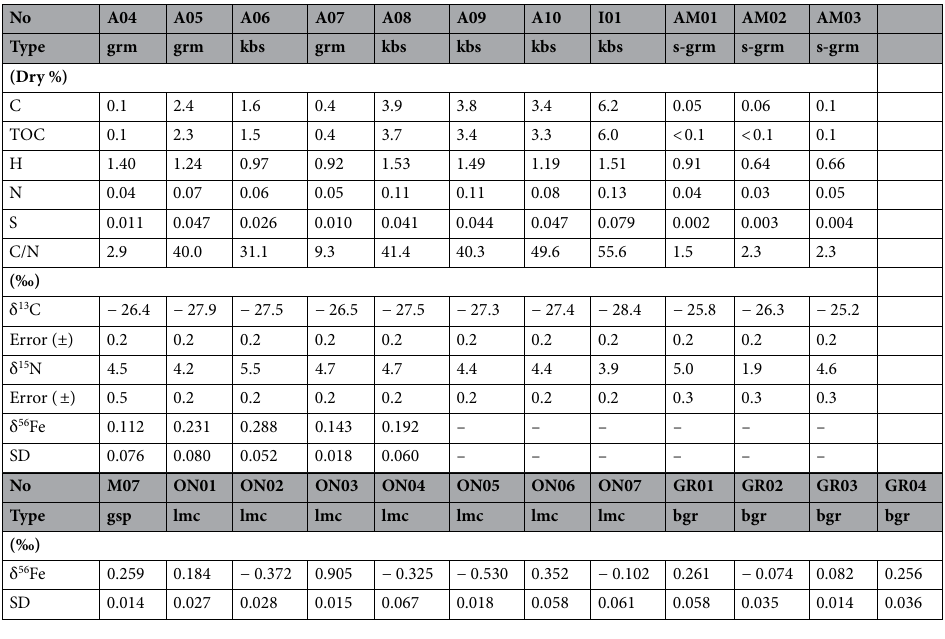
Table 1. Analytical results of C, TOC, H, N, S concentrations, and C, N, Fe stable isotopes. TOC total organic carbon, grm gaerome, kbs kibushi, s-grm silicic gaerome, gsp green saprolite, lmc limonite crust, bgr basement granite, SD standard deviation. –: not analyzed, C/N: molar ratio of carbon and nitrogen.